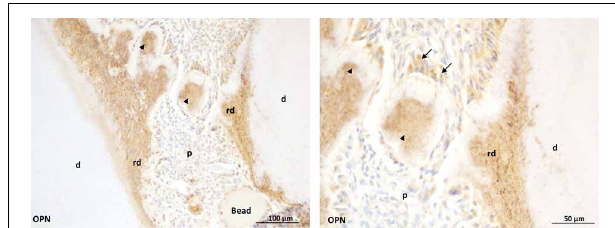
FIGURE 3 | Early dentin repair in an injured rat pulp model induced by the implantation of C-DMP1 peptide mimicking an MMP2 cleaved peptide of DMP1.Beads soaked with c-DMP1 polypeptide were implanted in the injured pulp of young rats. At day 7, osteopontin (OPN) immunohistochemistry shows strong immunoreactivity of reparative structures (arrowheads) observed in the injured pulp resembling mineralization foci (Mckee et al., 1993). Bridge formation at longer time points may partly result from growth and spreading of these mineralization foci. At higher magnification (right panel), immunopositive cells (arrows) are observed adjacent to the reparative structures.p: pulp; rd: reactionary dentin; d: